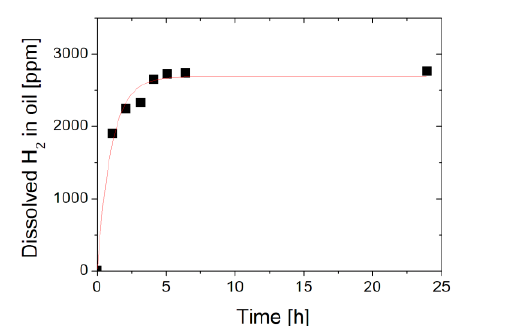
Figure 4. Uptake of hydrogen in oil by bubbling 5% H 2 in N 2 gas mixture through